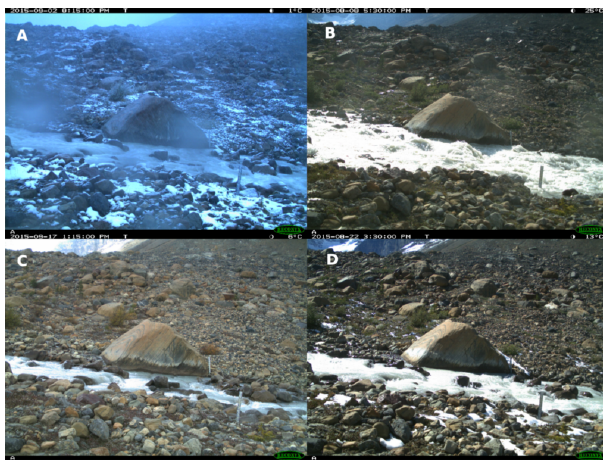
Figure 4. Images illustrating the main issues affecting image quality and measurements during the stage and width calculation: (a) heavy weather conditions, (b) boulder shadow and intense water reflec- tion, (c) emerged rocks on the main channel at low flows and (d) light snow cover on the edge of the stream.